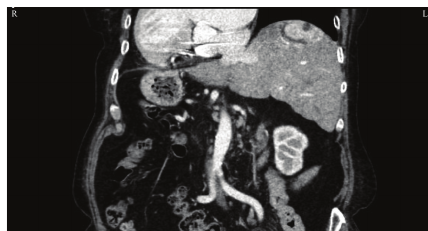
Figure 2: Coronal CT images of angiomyolipoma in a patient with situs inversus